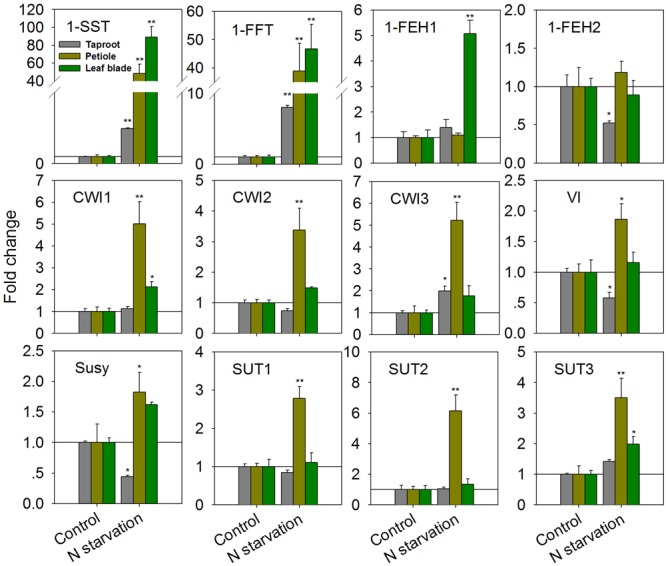
Impact of nitrogen starvation (10 days) on transcript levels of FAZYs (1-SST, 1-FFT, 1-FEH1 and 1-FEH2), sucrose-cleaving enzymes (CWI1-3, VI, Susy) and sucrose transporter isoforms (SUT1-3) in leaf blades, petioles and taproots of 38-day-old chicory seedlings. Transcript levels were determined by qPCR, normalized against the expression of two reference genes (Actin and RPL19), and plotted as fold change relative to the control which was set to 1 as indicated with as horizontal line. Bars indicate means ± SD of three independent experiments. Asterisks represent significant differences as determined by Student’s t-test (∗P < 0.05; ∗∗P < 0.001).